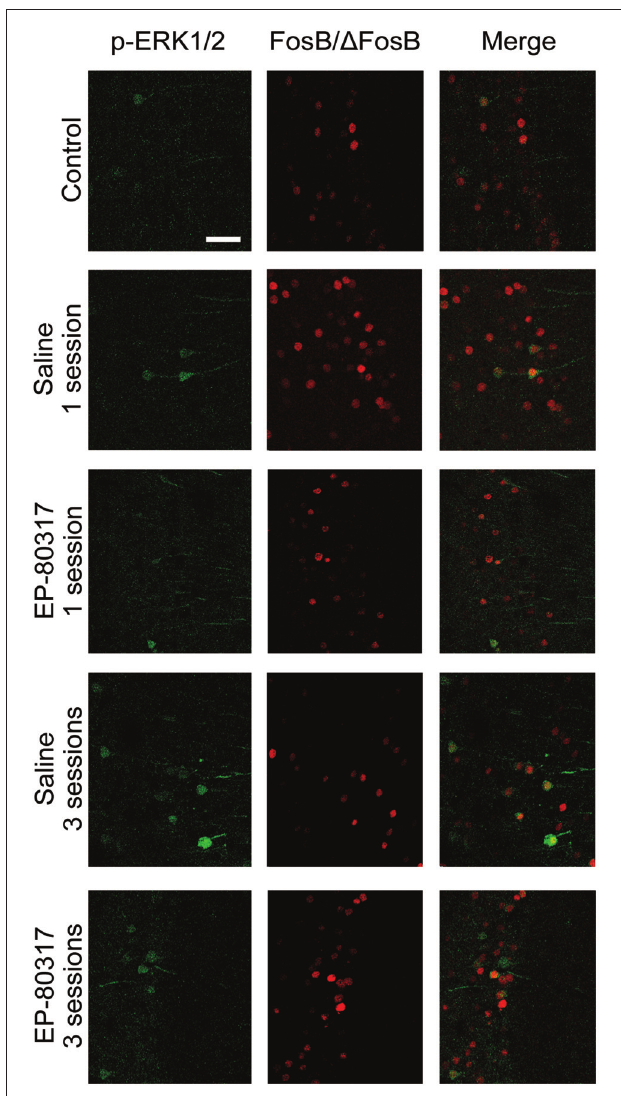
FIGURE 5 | Double immunofluorescence confocal laser scanning micrographs of mice exposed to repeated 6-Hz corneal stimulation. Photomicrographs illustrating co-labeling with phosphorylated extracellular signal-regulated kinases 1/2 (p-ERK1/2) (green) and FosB/ ∆ FosB (red) in CA1 of representative mouse for each group of treatment. Double-label immunofluorescence revealed the coexpression of p-ERK1/2 and FosB/ ∆ FosB in the experimental groups. Scale bar, 75 µ